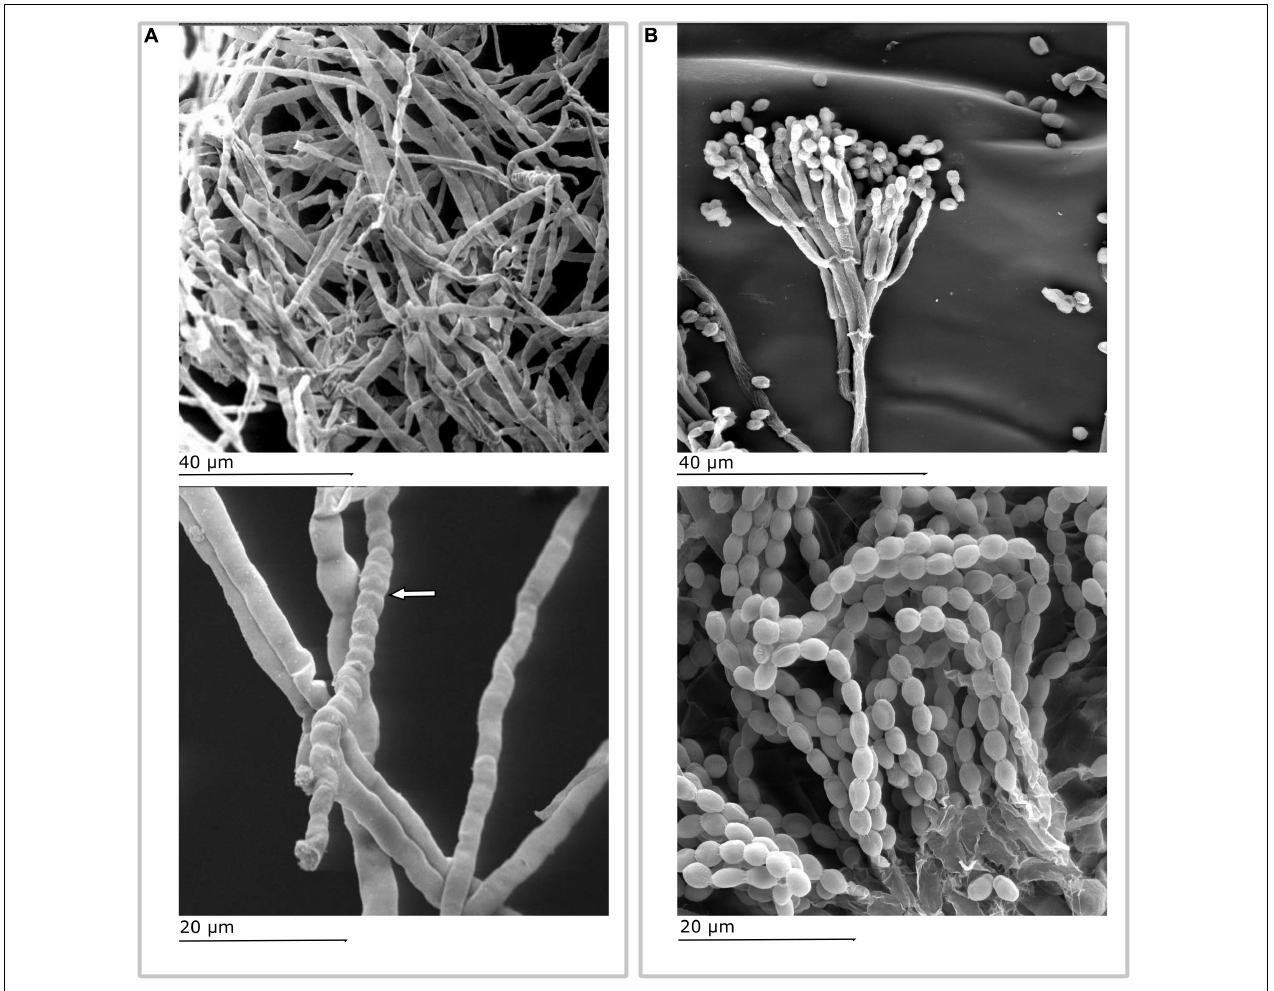
FIGURE 4 | Scanning electron microscopy images: (A) Fusarium spp. mycelium. In highlight (white arrow), the presence of chlamydospores characterized by a thickened wall and rich in reserve substances capable of surviving in adverse environmental conditions and remain quiescent for long periods waiting for favorable conditions; (B) Penicillium spp.: typical branched conidiophore with chains of